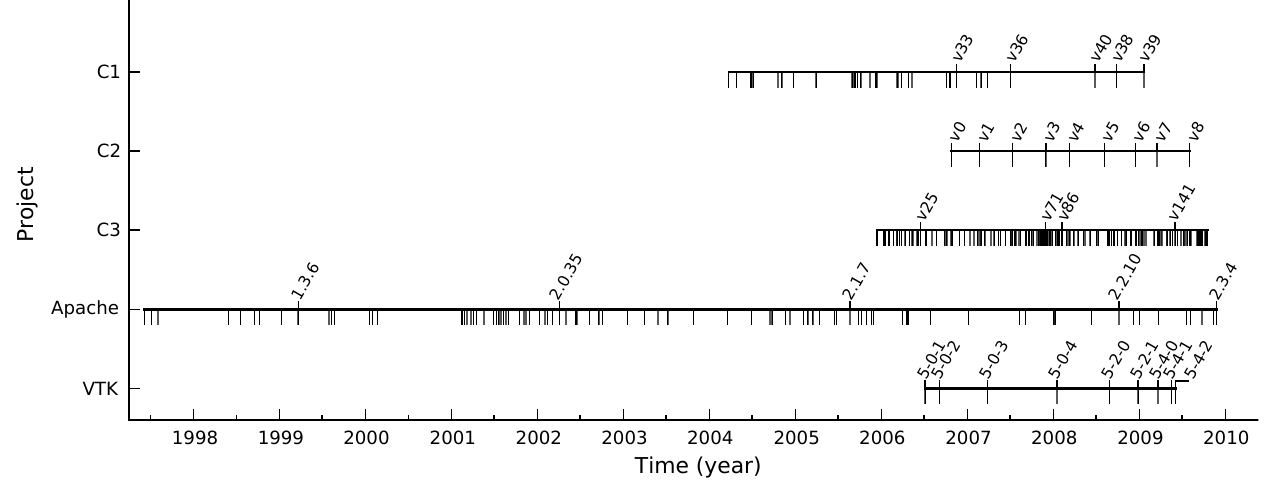
Fig. 2. Project repository time lines. Candidate versions are marked on the timelines with downward ticks, and analysed versions are labelled.